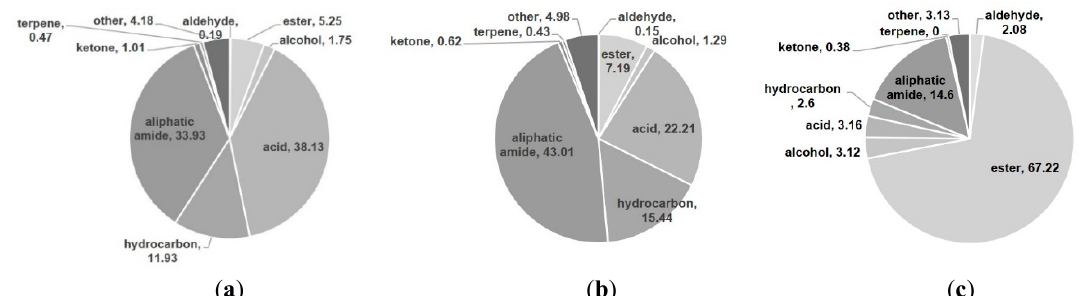
Figure 2. Relative content (%) of volatile compounds in ( a ) “golden ring”; ( b ) “pumpkin pie”; ( c ) “snow chrysanthemum”.